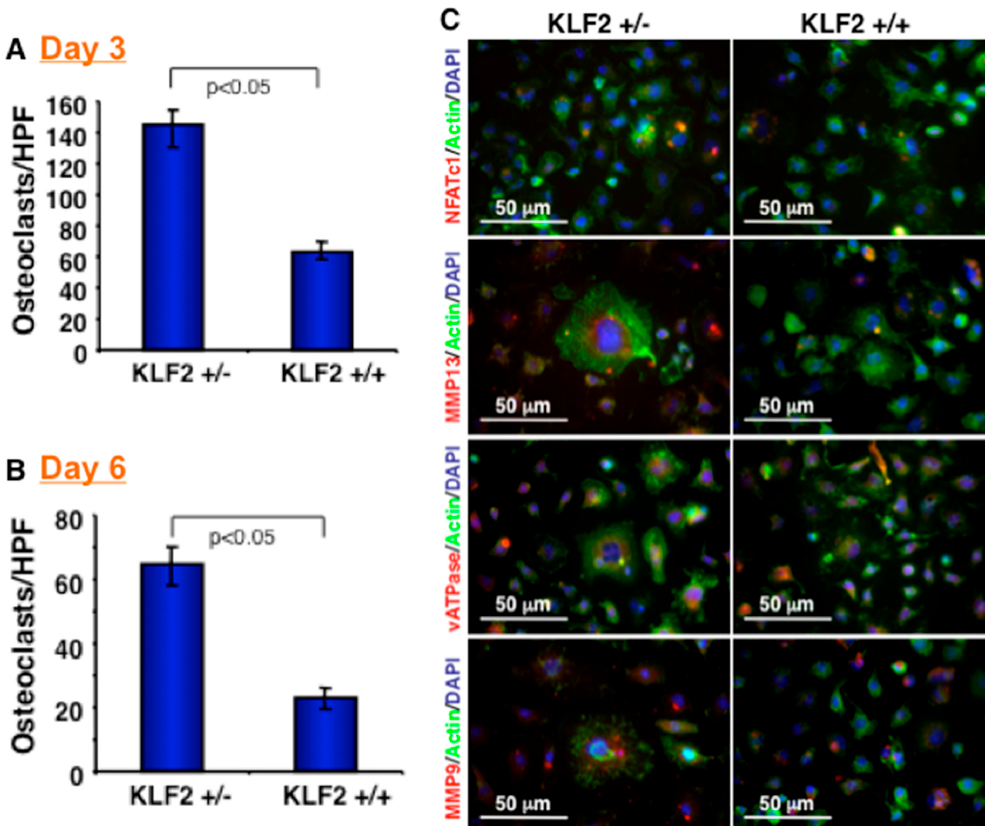
Figure 2. KLF2 hemizygocity enhanced osteoclast differentiation and maturation. ( A ) Osteoclast precursor cells were harvested from femurs of KLF2 +/ − and KLF2 +/+ mice after termination of K/BxN serum-induced arthritis, and osteoclasts were induced to differentiate. After tartrate-resistant acid phosphatase (TRAP) staining, the number of differentiated osteoclasts were measured and graphically presented at day 3. ( B ) Number of differentiated osteoclasts were measured and graphically presented at day 6. ( C ) Differentiated osteoclasts were stained for various osteoclast-related markers.